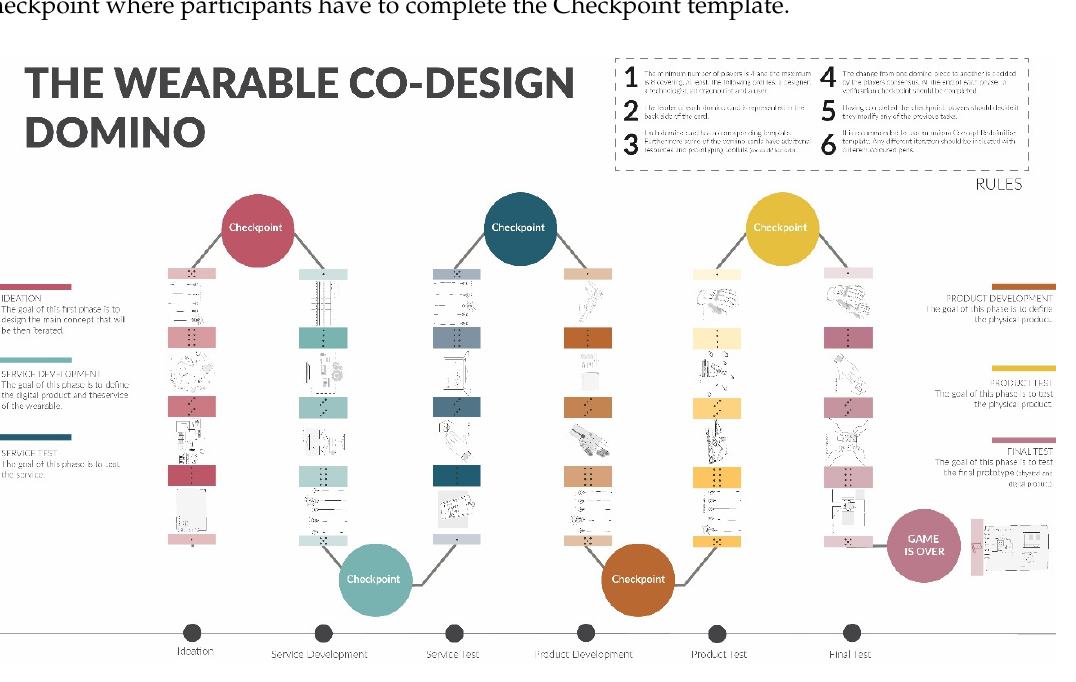
Figure 9. Photo of the We Co-Do Handbook.